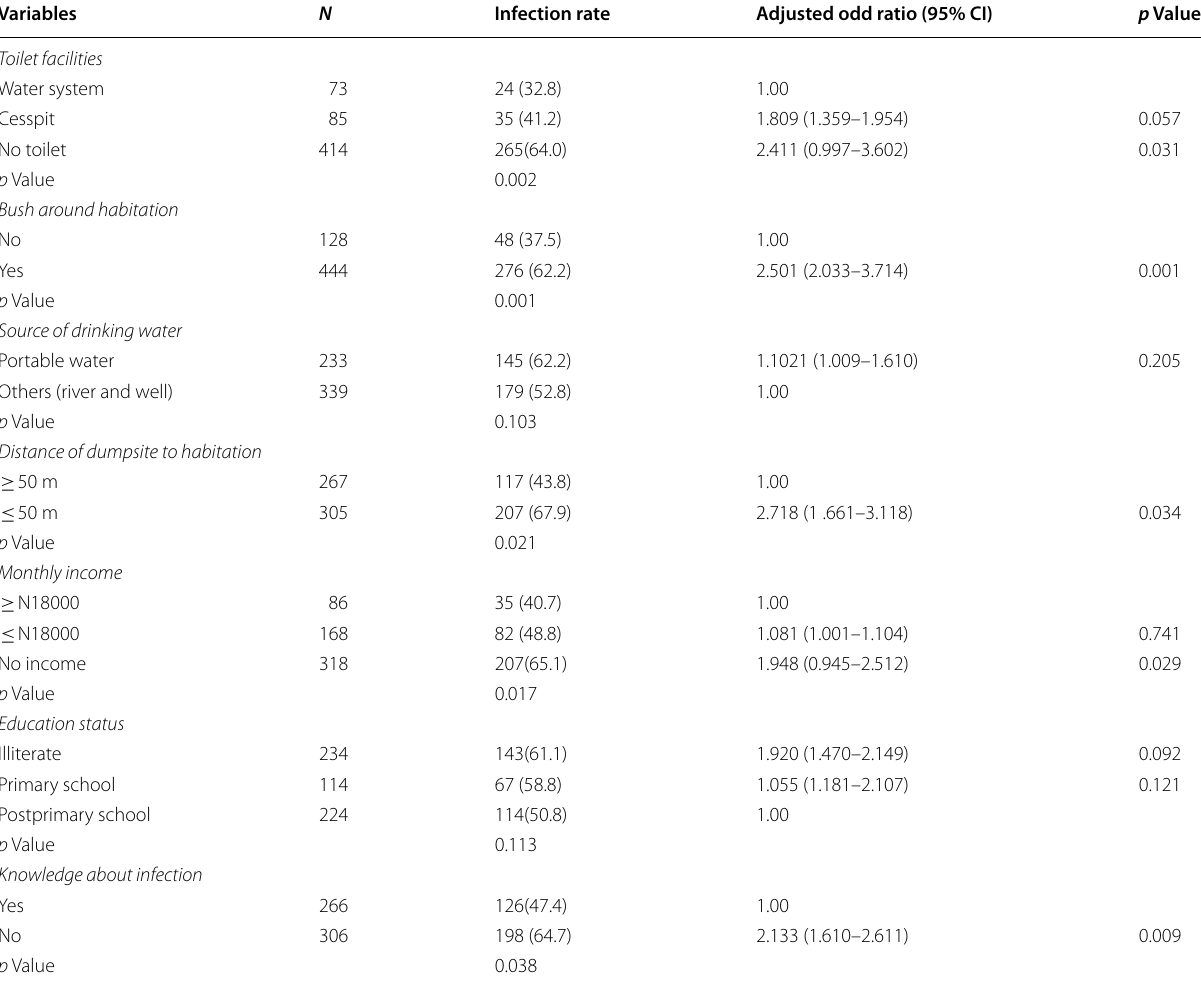
Table 2 Prevalence of malaria infection and logistic regression analysis of socioeconomic and environmental factors of individuals